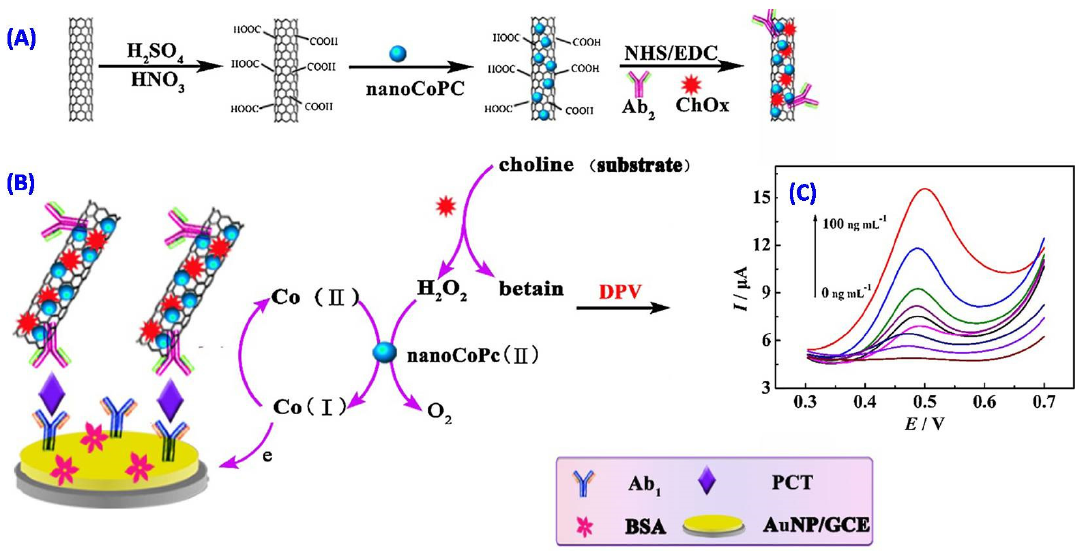
Figure 7. ( A ) Preparation steps involved in the fabrication of ChOx/Ab 2 /nanoCoPc-MWCNTs bioconjugates. ( B ) Fabrication process of electrochemical immunosensor and the amplification mechanism of detection signal. ( C ) DPV responses recorded for the immunosensor after incubating with different concentrations of PCT from 0.01 to 100 ng/mL under optimized conditions [33].